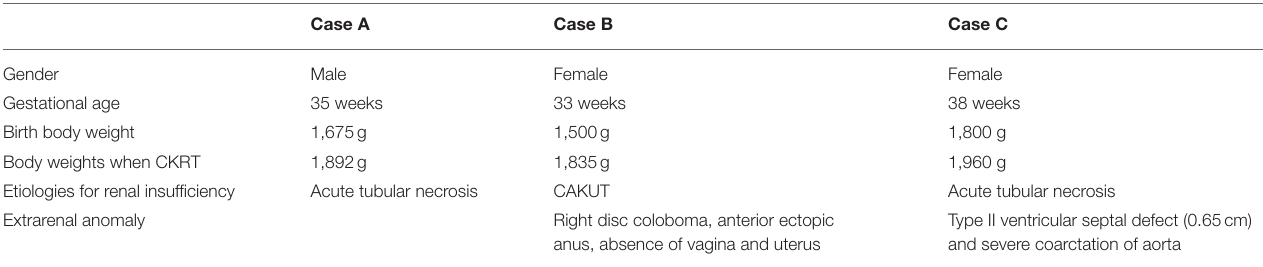
TABLE 1 | Clinical characteristics of our three